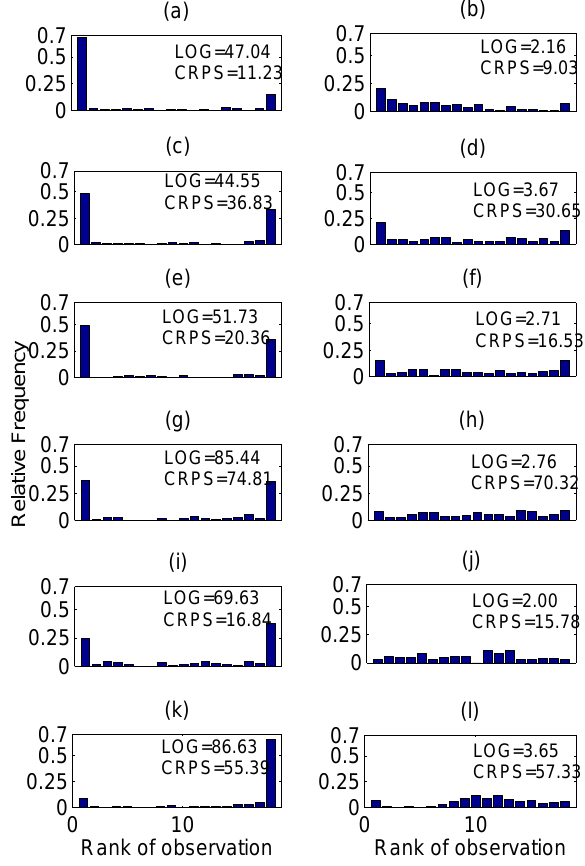
Fig. 8. Rank histograms for 2-days ahead ensemble hydrologic forecasts before and after post-processing, (a) Chelsea before post- processing (b) Chelsea after post-processing (c) Paugan before post-processing (d) Paugan after post-processing (e) Maniwaki be- fore post-processing (f) Maniwaki after post-processing (g) Baska- tong before post-processing (h) Baskatong after post-processing (i) Cabonga before post-processing (j) Cabonga after post-processing (k) Ceizur before post-processing (l) Ceizur after